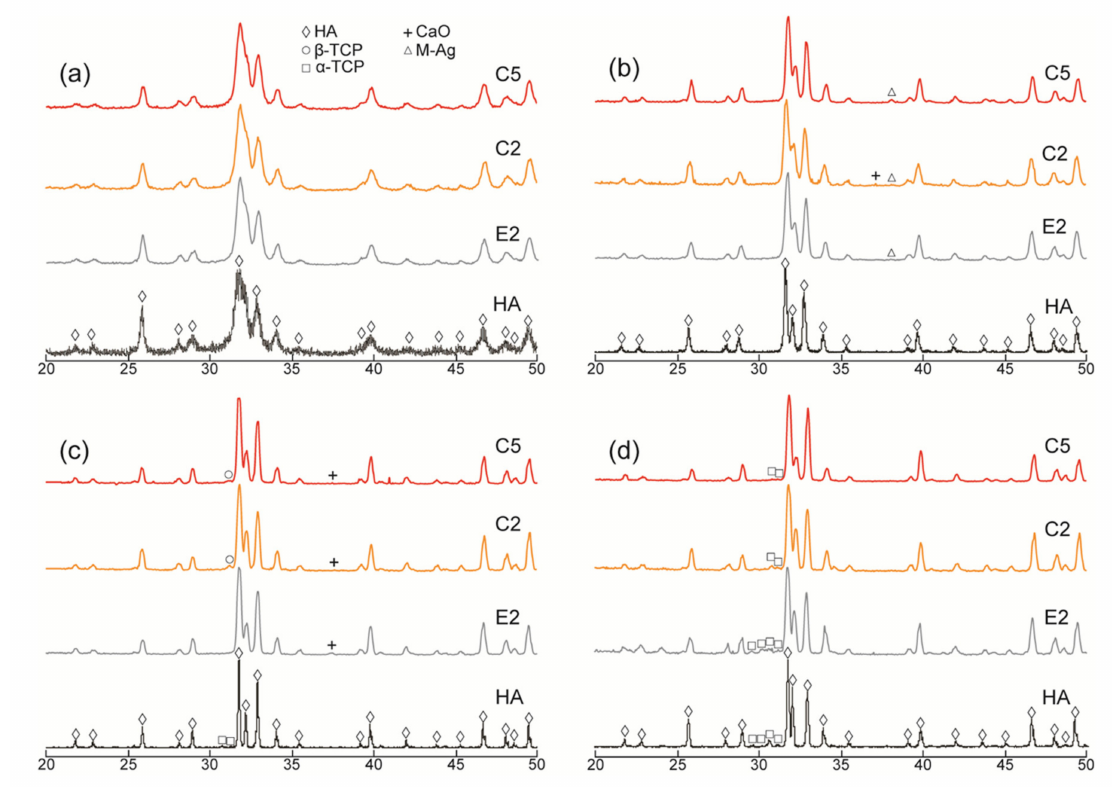
Figure 1. XRD patterns of the Ca-deficient (C2 and C5) AgHAs compared to E2 and pure HA heat-treated at ( a ) 700 ◦ C, ( b ) 900 ◦ C, ( c ) 1100 ◦ C, and ( d ) 1300 ◦ C. Y-axis: arbitrary